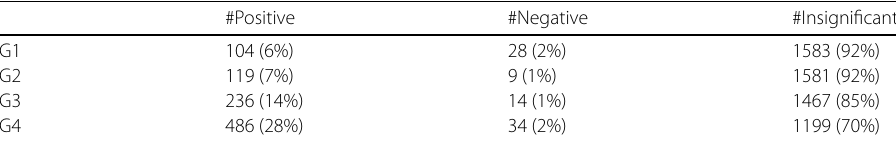
Table 12 Dependency of the susceptibility distribution on the posting rate for Twitter #Positive #Negative